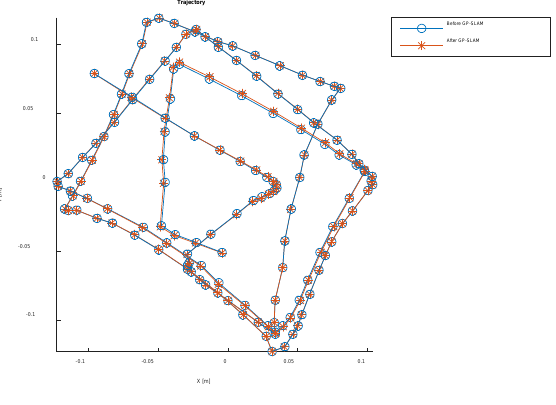
Figure 12: Estimated rectangular trajectory pattern in a homogeneous magnetic field